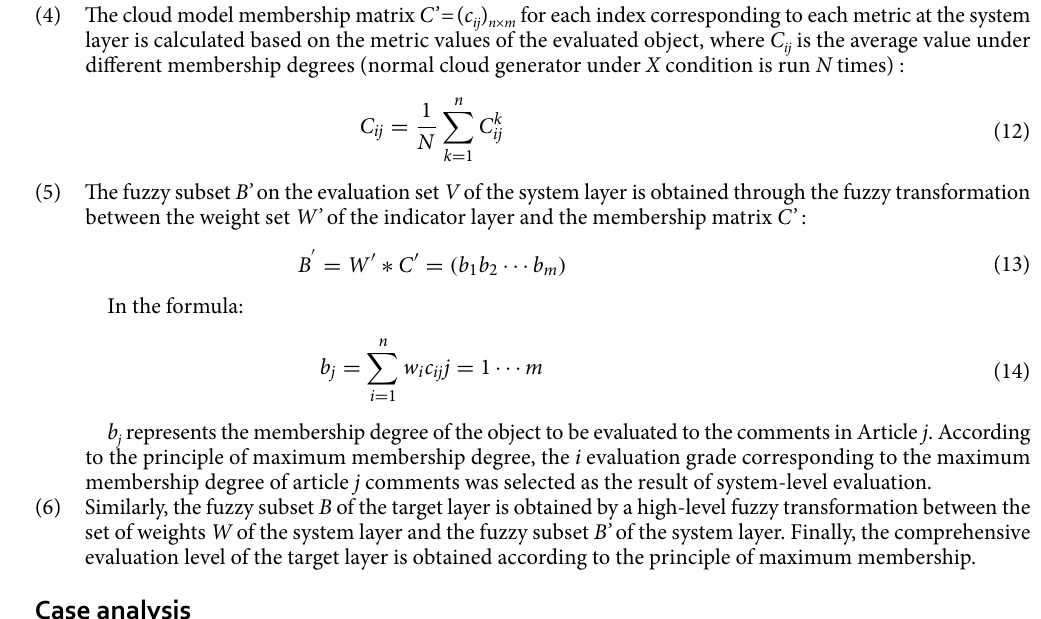
Table 7. In order to ensure the objectivity and comparability of the evaluation criteria of the indicators. In this paper, based on the sample data of 31 Chinese provinces and cities and the indicator values of the evaluation objects, the evaluation criteria of the resilience evaluation indicators of the evaluation objects are developed, as shown in Table 8. According to the established toughness index system and evaluation index standard of regional water supply system, the ranking criteria corresponding to each index can be represented by the normal cloud model cor- responding to Eqs. (9) and (11), as shown in Table 9. Multi-level comprehensive evaluation based on the cloud model. According to the